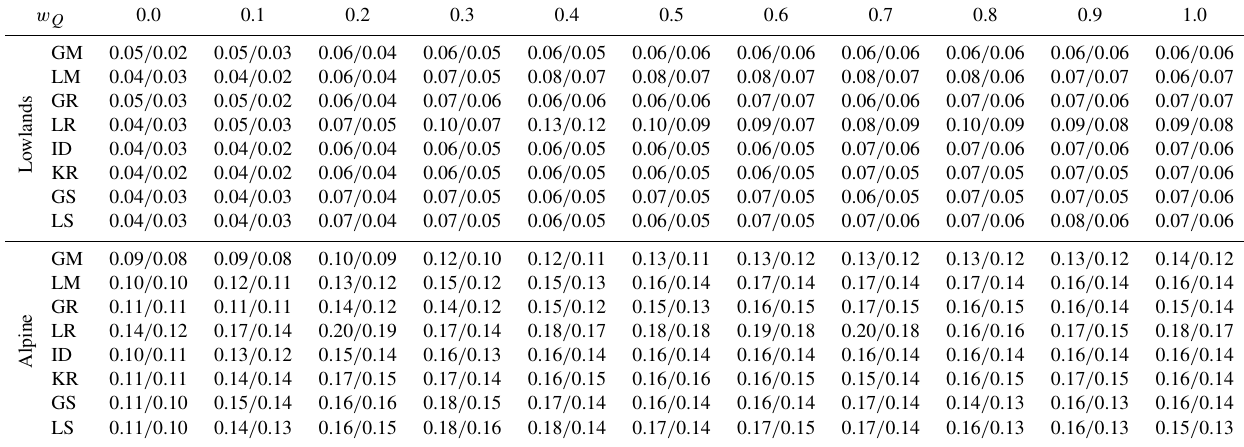
Table 5. Scatter (difference of 75% and 25% quantiles of model efficiency) of the leave-one-out snow model efficiency (Eq. 9) obtained by eight groups of parameter transfer methods and 11 calibration weights for lowland (94) and alpine (119) catchments in the calibration (2000–2010; first value) and validation (2010–2014; second value)